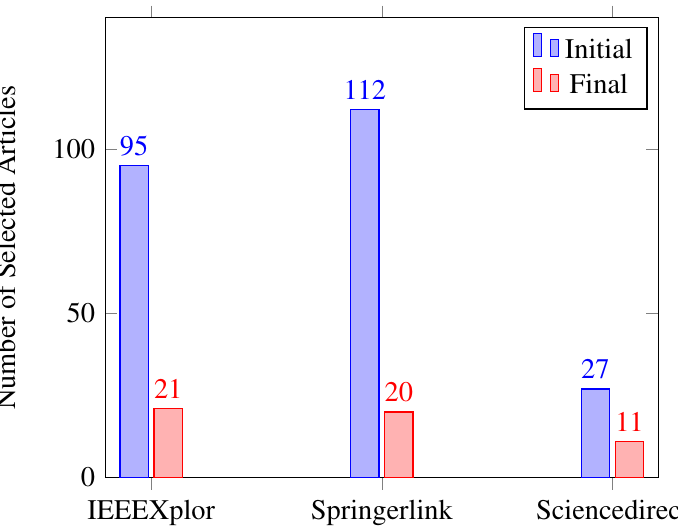
Figure 2. Proportion of selected studies